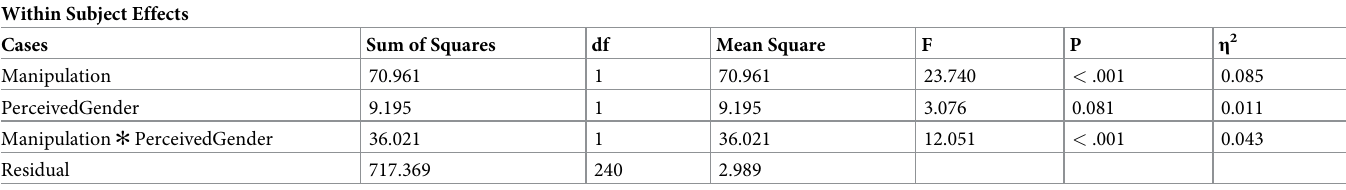
Table 5. ANOVA comparing ratings of narratives of psychological violence for the original version, and the gender reversed version (Phase 2 and